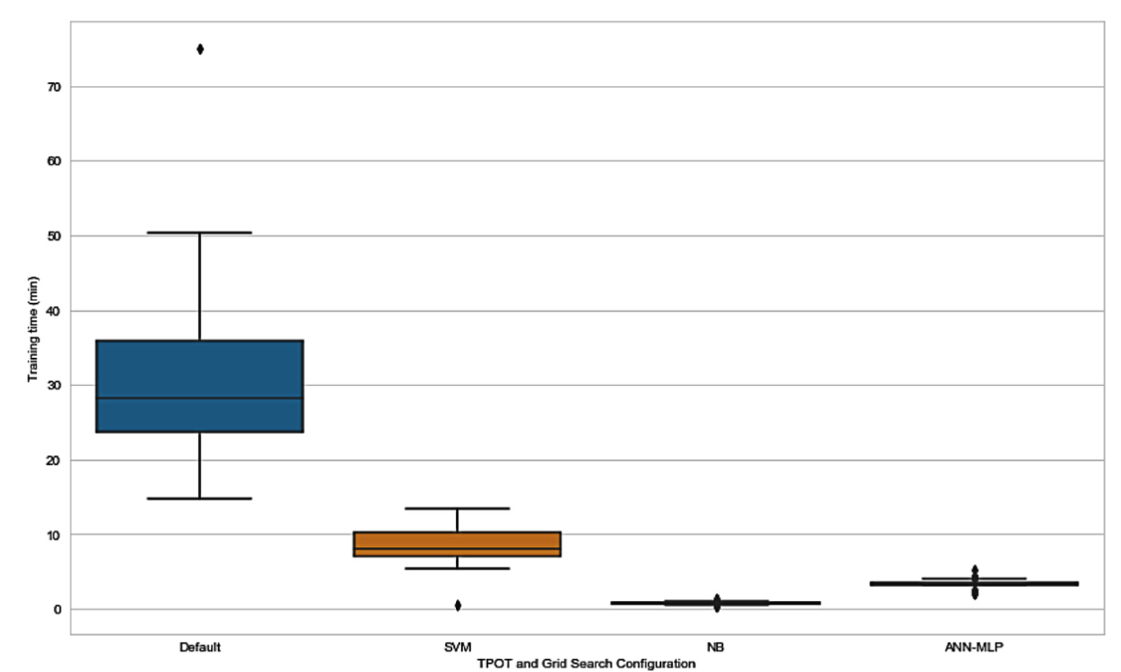
Figure 8. CPU clock time distributions for training TPOT on each configuration.